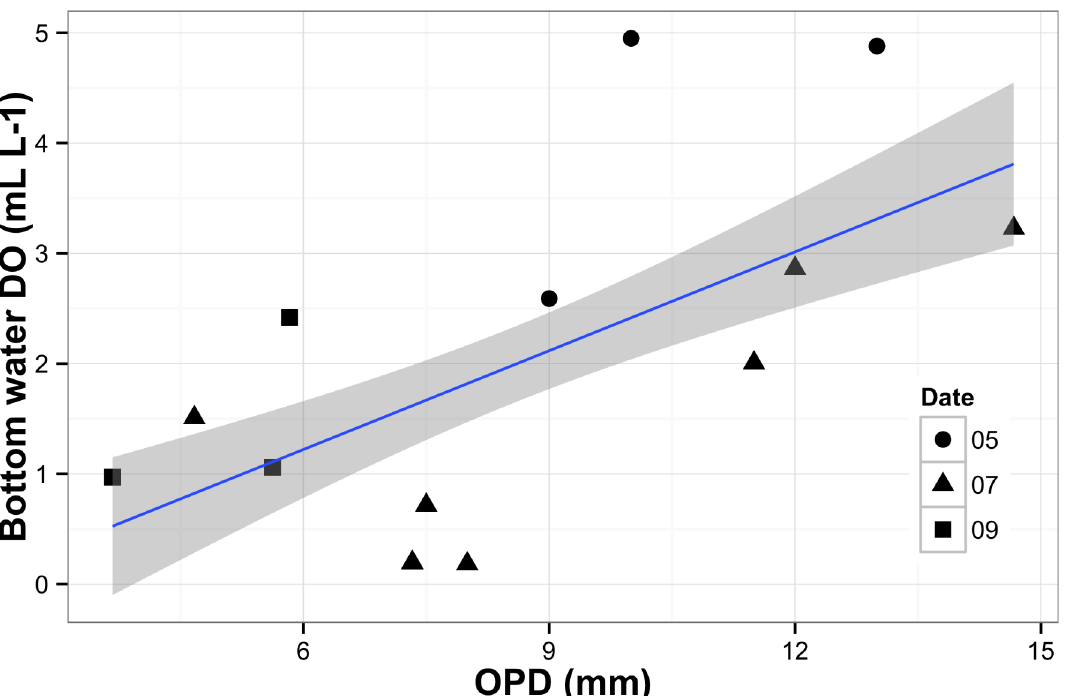
Fig 7. Relationship between oxygen penetration depth (OPD) and bottom water dissolved oxygen (Bottom DO). Grey shaded area around regression line indicates 95% confidence interval. Sample collection date: May 2011 (circles); July 2011 (triangles); September 2013